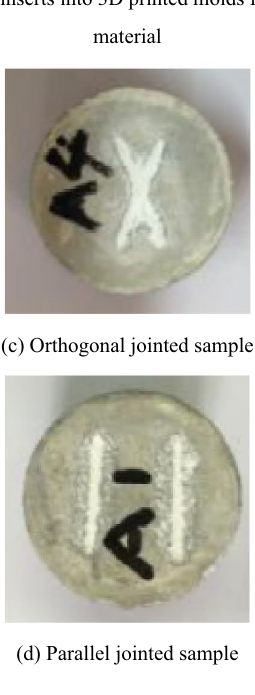
Fig. 3 Casted sample with 3D printed joint mold (Zhao et al. 2017)